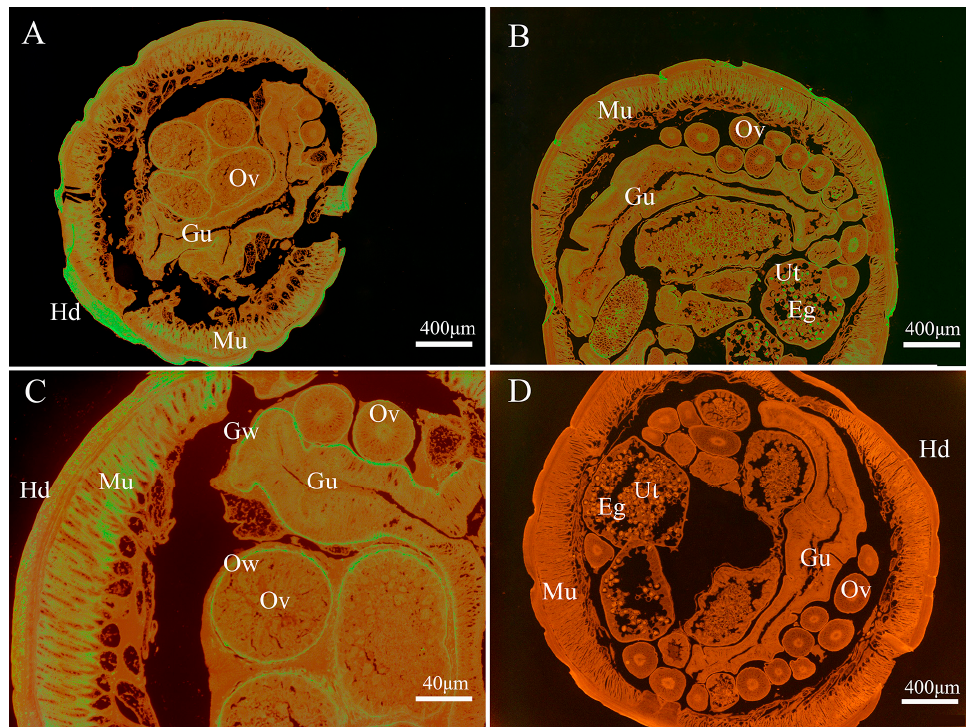
Figure 5. Immunolocalization of B. schroederi Tpx (Bs-Tpx) . The sections (5- μ m thickness) were incubated with rabbit anti-recombinant Bs -Tpx (anti-r Bs -Tpx) IgG (1:100; panels A , B and C ), pre-immune rabbit IgG at (1:100; panel D ). Panel C represented the magnified part of panel A. The endogenous Bs -Tpx becomes visible with fluorescein isothiocyanate (FITC)-labeled goat anti-rabbit IgG (1:100). Abbreviations: Eg, egg; Ut, uterus; Mu, muscle; Hd, hypodermis; Ov, ovary; Ow, ovarian wall; Gu, gut; Gw, gut wall.